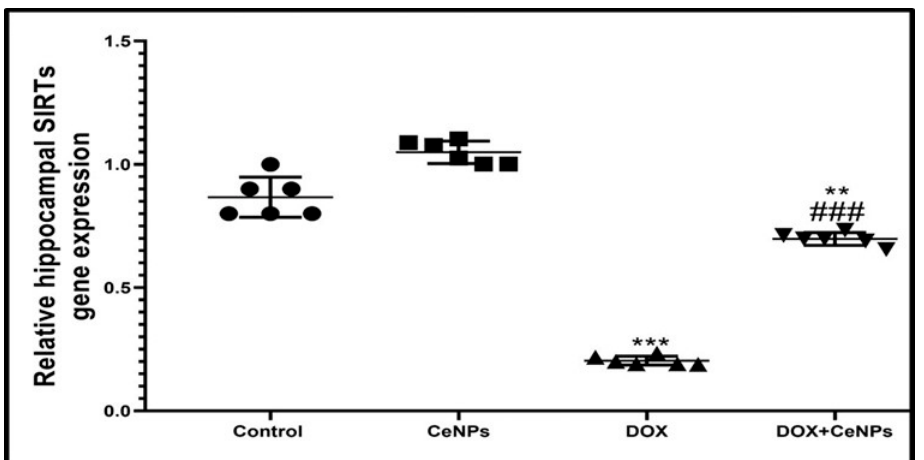
Figure 13. Effect of nanoceria treatment on relative gene expression of SIRT-1 in different groups of rats. Data are expressed as mean ± SD. One-way ANOVA test followed by Tukey’s post hoc test was used for data investigation, *** p < 0.001, ** p < 0.01, and * p < 0.05 vs. control group, ### p < 0.001, ## p < 0.01, and # p < 0.05 vs. DOX group.